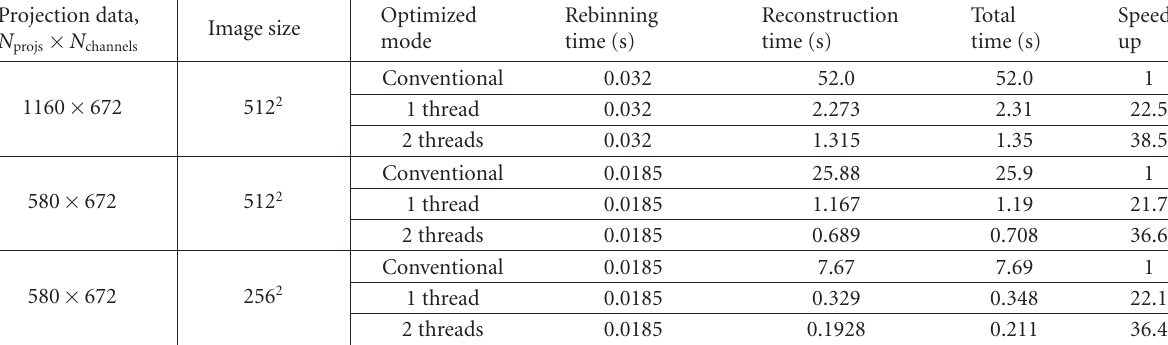
Table 4: Speedup comparison on HP 6200 workstation (2 Xeon 3.2 GHz